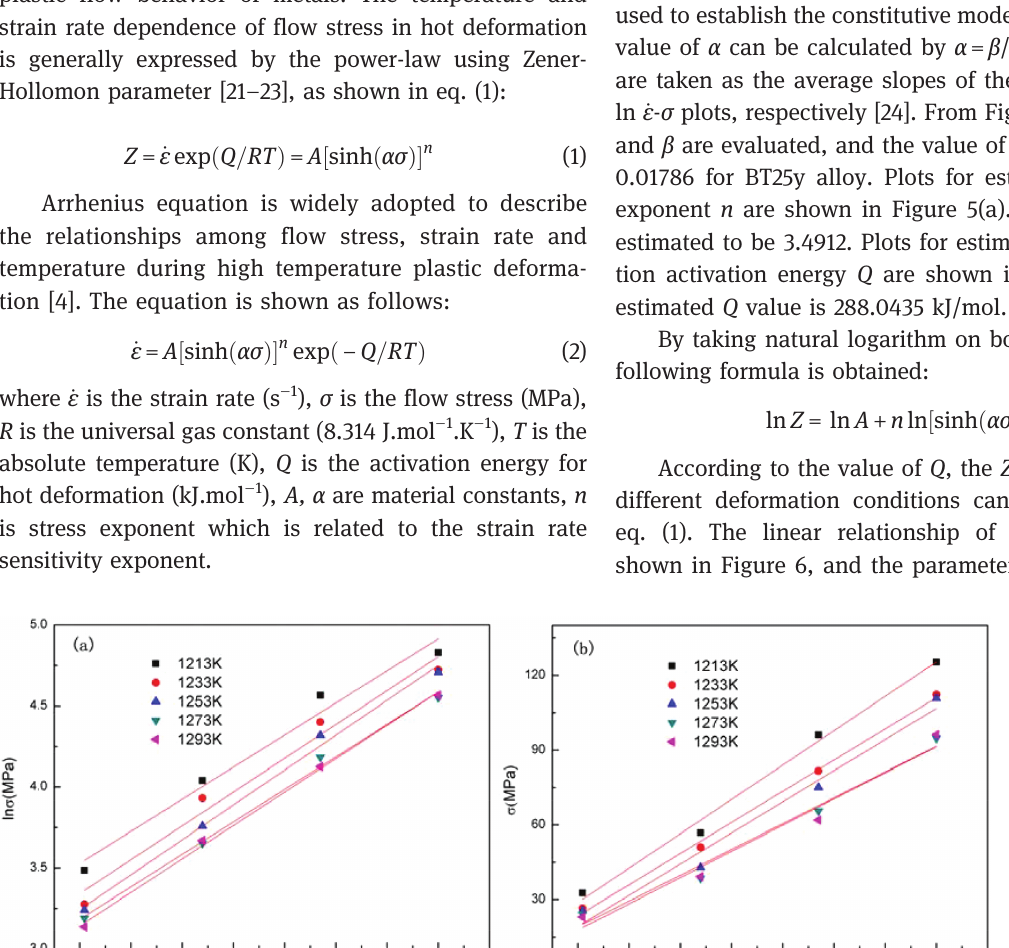
Figure 4: (a) Relationship between ln σ and ln _ ε at different tempera- tures; (b) Relationship between σ and ln _ ε at different temperatures.